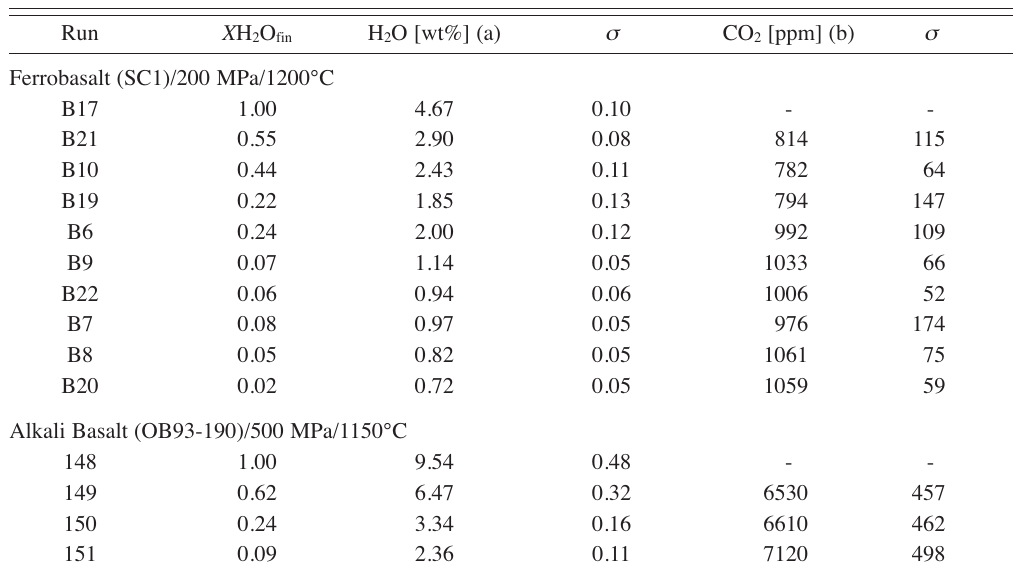
Table A.II. Experimental results.